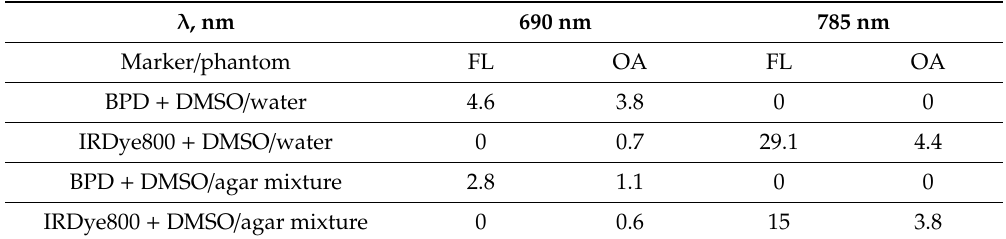
Table 2. Weber contrast calculated by the fluorescence imaging (FL) and optoacoustic (OA) images of the phantom for probing wavelengths of 690 and 785 nm.